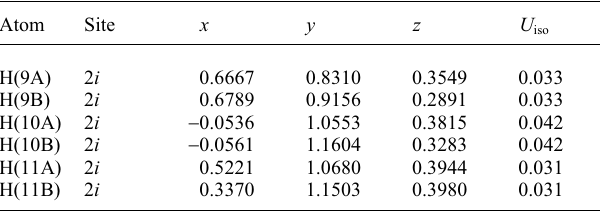
Table 2. Atomic coordinates and displacement parameters (in Å 2 ) .